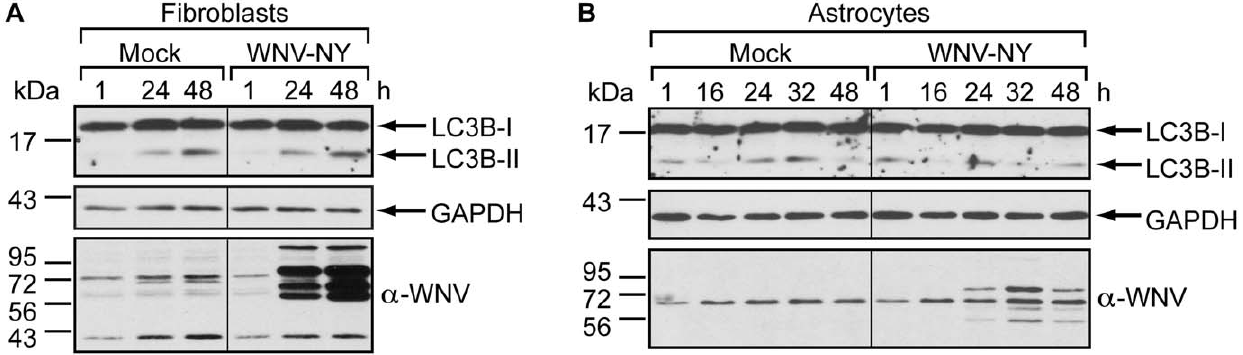
Figure 7. Primary human cell lines do not upregulate autophagy in response to WNV infection. (A-B) Effect of WNV infection on steady- state LC3B-II levels. Human foreskin fibroblasts (A) or human brain cortical astrocytes (B) were mock-infected or infected with WNV-NY (MOI=3). Following infection, cells were grown in medium containing 10 m g/mL Pepstatin A and E64d. Whole cell lysates prepared at the indicated times (h) post-infection were subjected to immunoblot analysis for expression of LC3B (top), GAPDH (middle) and WNV